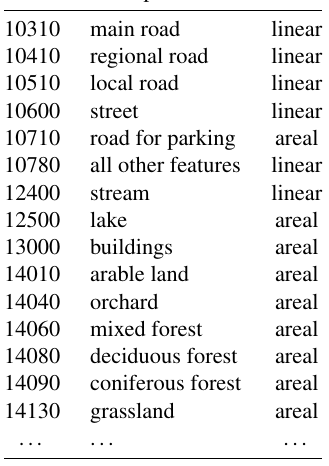
Table: generalization actions. This is the core table for record- ing which class should undergo which generalization opera- tion at what scale (see Table Table 1. Example ‘feature class’ table. The classes are taken from Top10NL (Dutch topographic data set intended to be used at scale 1: 10 , 000 ).